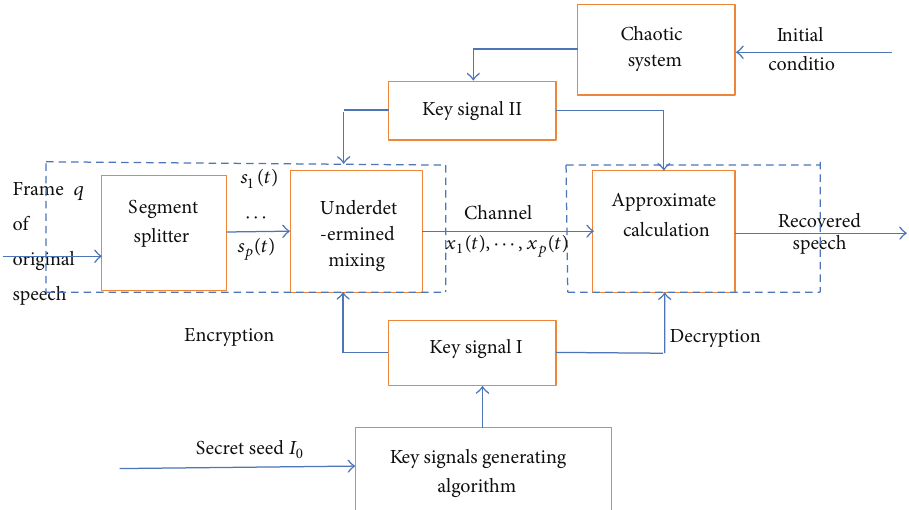
Figure 1: Block diagram of underdetermined BSS-based double key speech